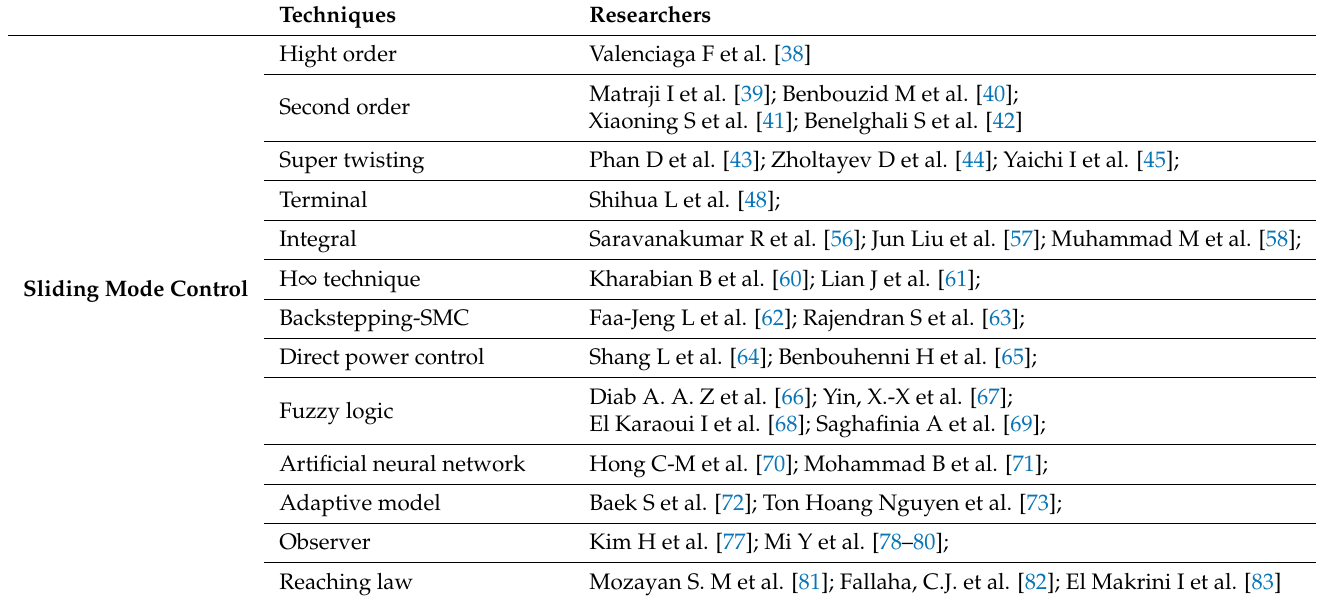
Table 1. Various techniques used for SMC